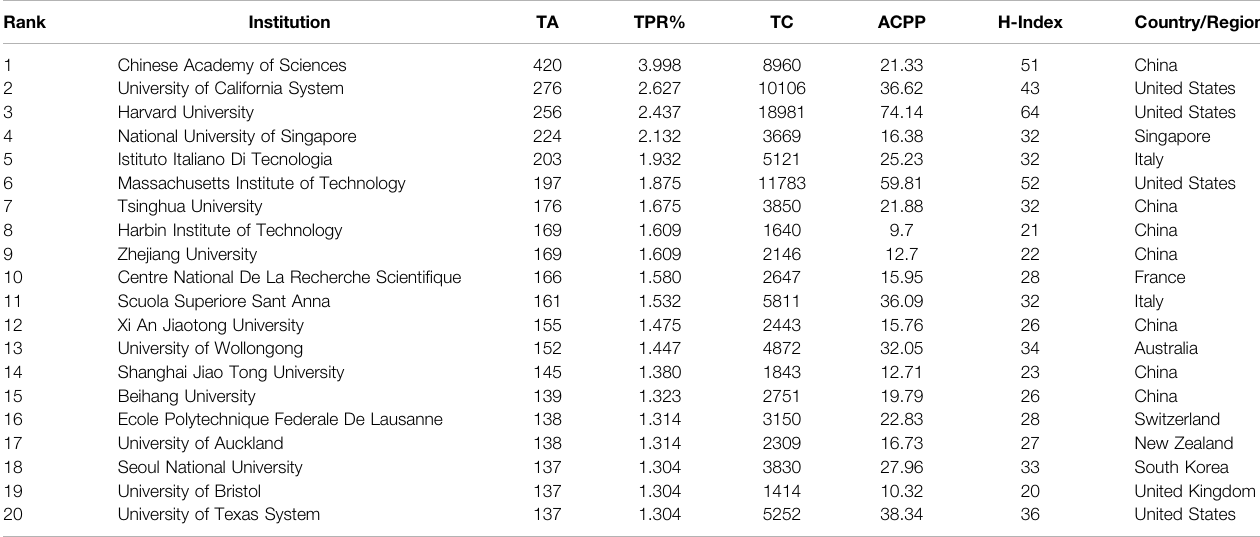
TABLE 2 | The Top 20 Most productive institutions in soft robotics fi eld during 2010 –